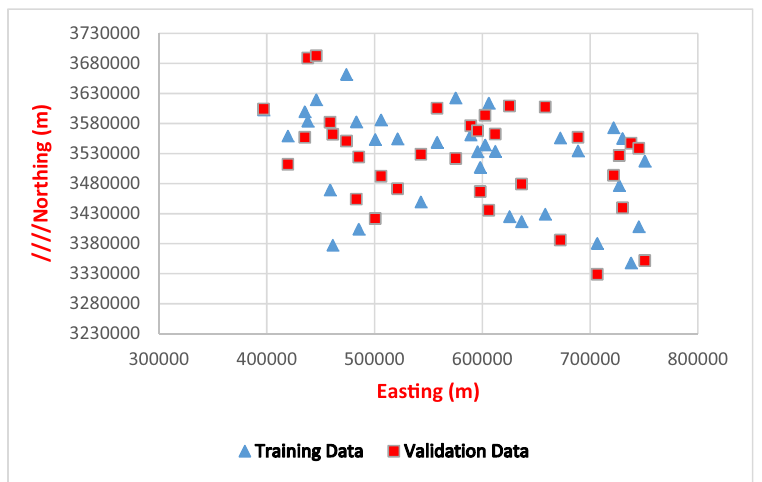
Figure 7: Distribution of training and validation